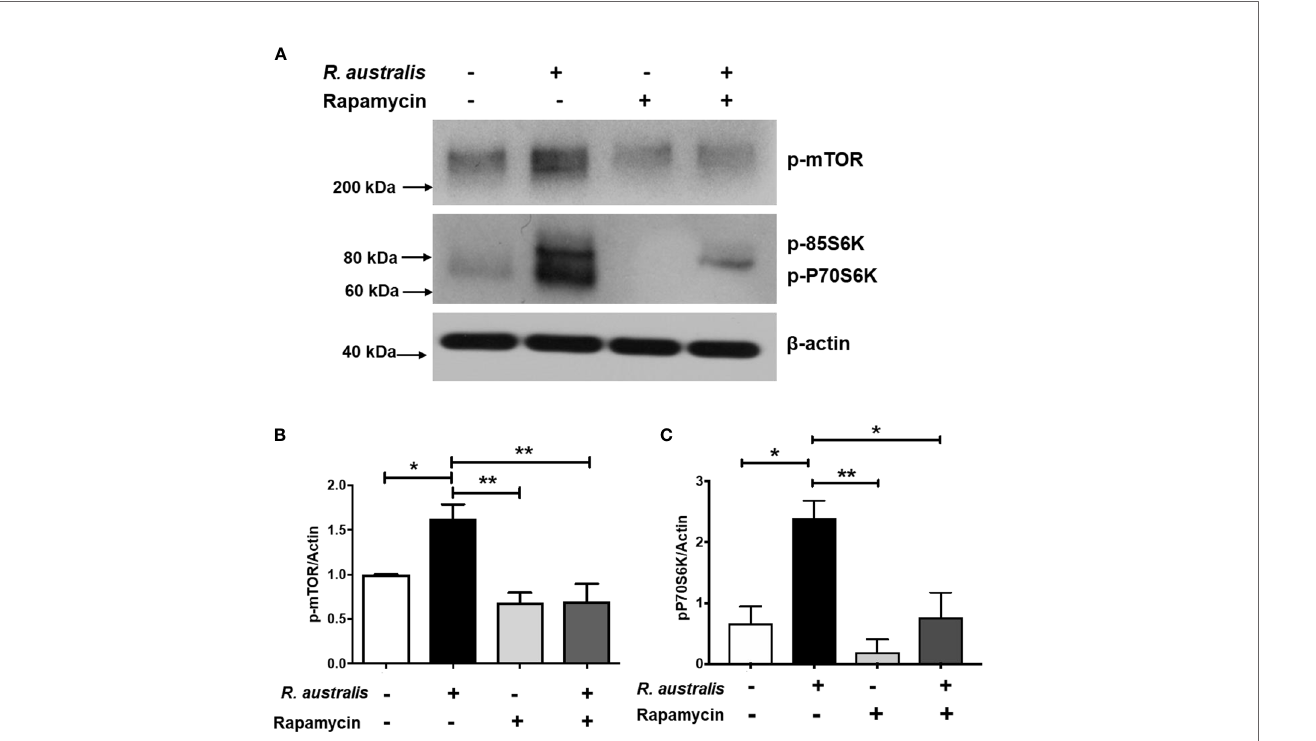
FIGURE 6 | (previous Figure 1). R. australis activates mTORC1 in mouse macrophages. BMMs of WT B6 mice were isolated and infected with R. australis at an MOI of 5. To inhibit mTORC1 signaling, cells were treated with 50 ng/mL of rapamycin for 4 hours prior to infection with R. australis . At 1 h p.i., cells were collected, and cell lysates were immunoblotted with antibodies directed against phosphorylated mTOR, phosphorylated p70S6K, and b -actin (A) . The activation of phosphorylated mTOR (B) and phosphorylated p70S6K (C) was analyzed by densitometry using b -actin as a normalization control with three independent replicates. * p < 0.05; ** p <